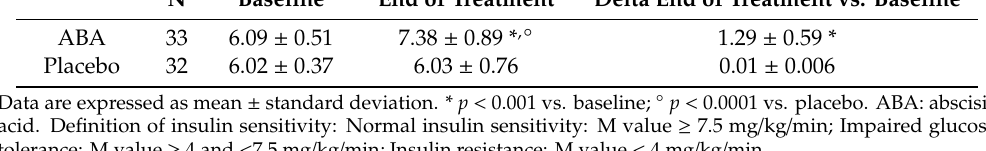
Table 3. M value variation during the study. N Baseline End of Treatment Delta End of Treatment vs. Baseline